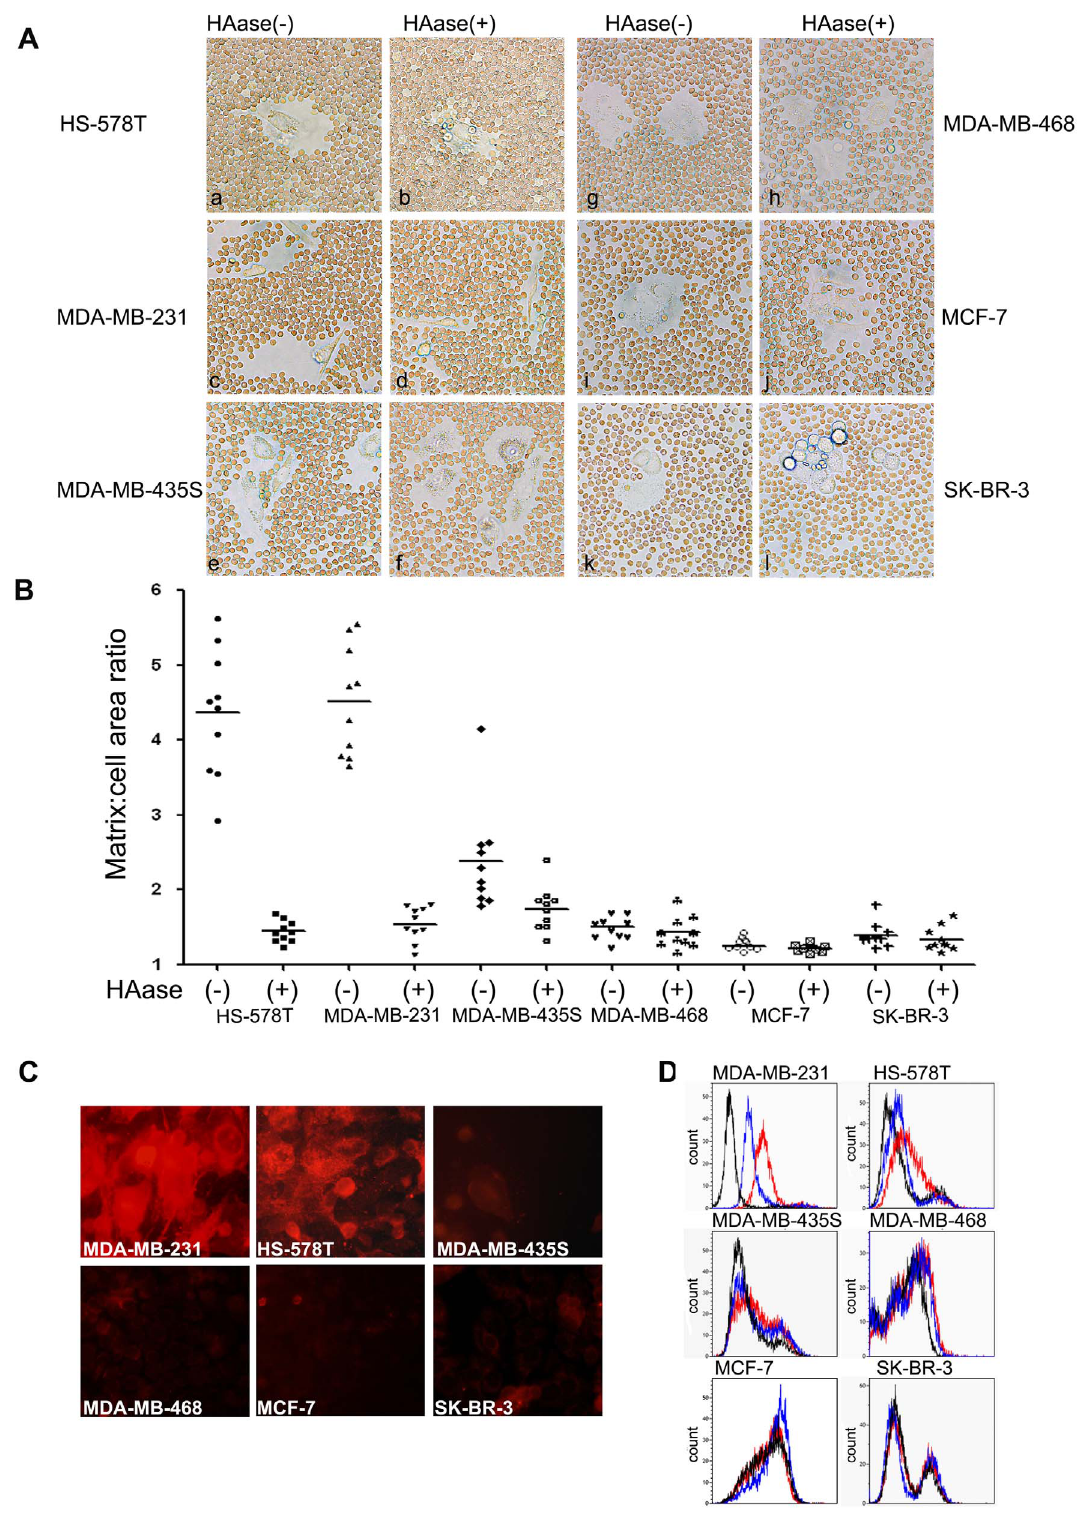
Figure 1. Breast cancer cell surface HA content was detected using three methods. (A) Visualization and morphometric analysis of HA matrices were performed using a particle-exclusion assay before and after the addition of HA-specific Streptomyces hyaluronidase. A clear zone was apparent between HS-578T, MDA-MB-231 cells and red blood cells (a, c); approximately 5 min after Streptomyces hyaluronidase was added to the cells, the HA coats were degraded, allowing the red blood cells to contact the HS-578T and MDA-MB-231 cells (b, d). No difference before (e, g, i, k) and after (f, h, j, l) the addition of Streptomyces hyaluronidase to MDA-MB-435S, MDA-MB-468, MCF-7, and SK-BR-3 cells was observed. (B) Surface HA retention was quantified as the ratio of matrix area to cell area. Individual breast cancer cells were traced using Image Pro Plus 6 at the boundary of